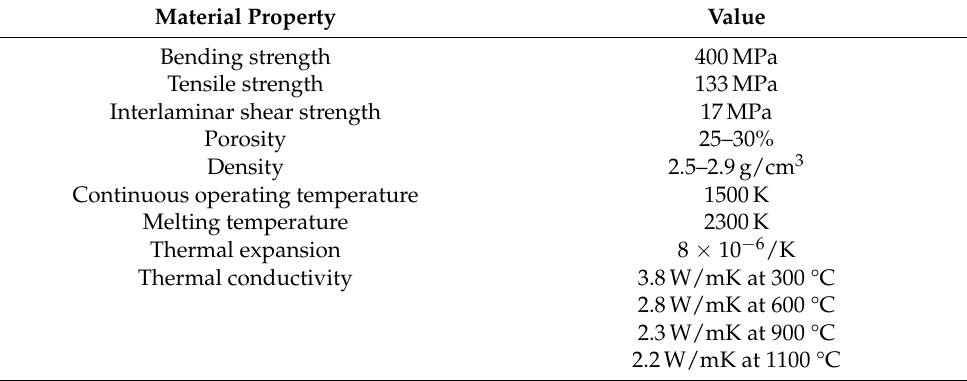
Table 2. Material properties of the OCMC FW12 (unless specified, all measures under room temperature)